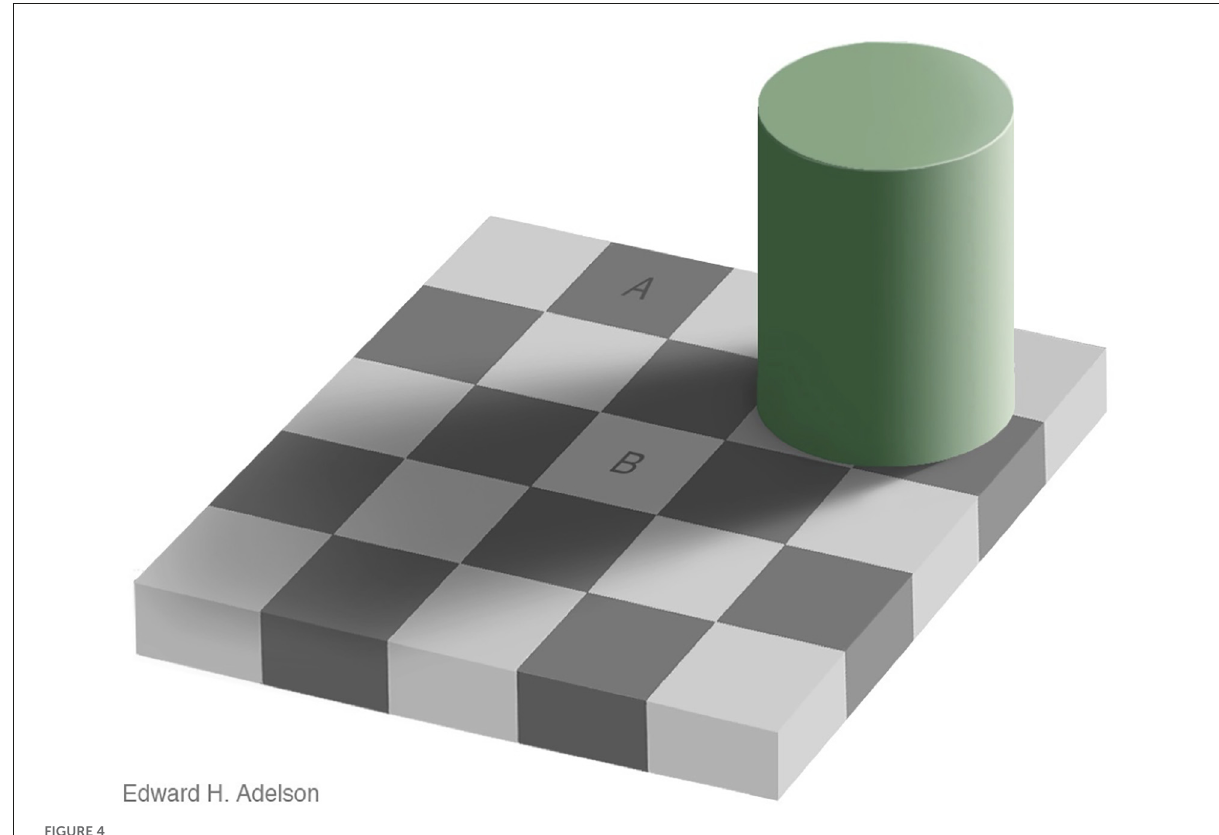
FIGURE4 Adelson’s checker shadow